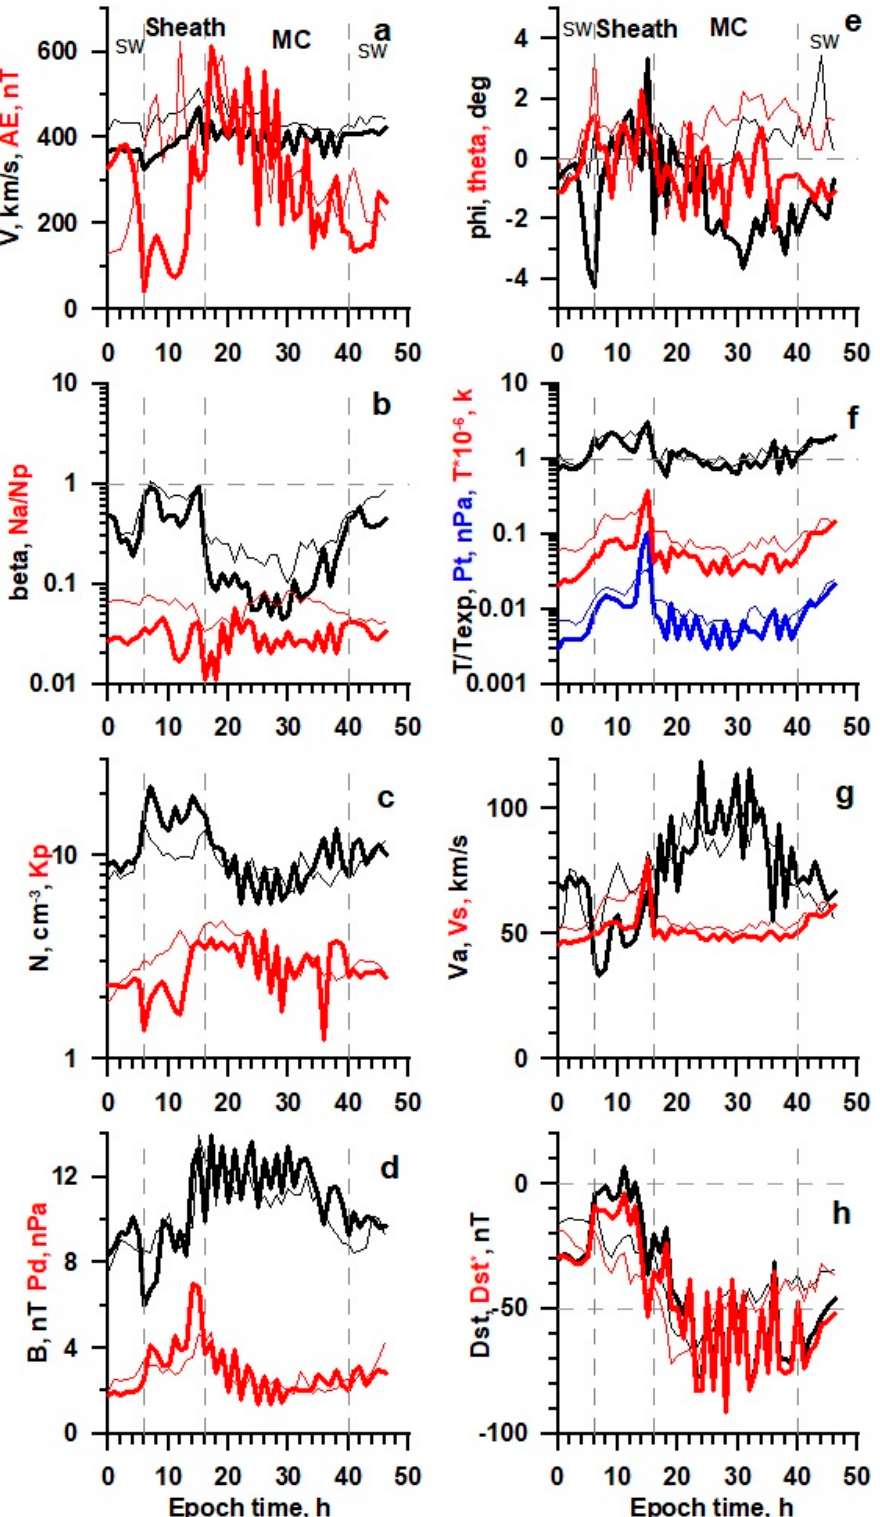
Figure 7. The temporal profile of solar wind and IMF parameters (see legend in the text) for Sheath/MC obtained by the double superposed epoch analysis for 15 events in 21–22 SCs (thin lines) and 6 events in 23–24 SCs (thick lines).